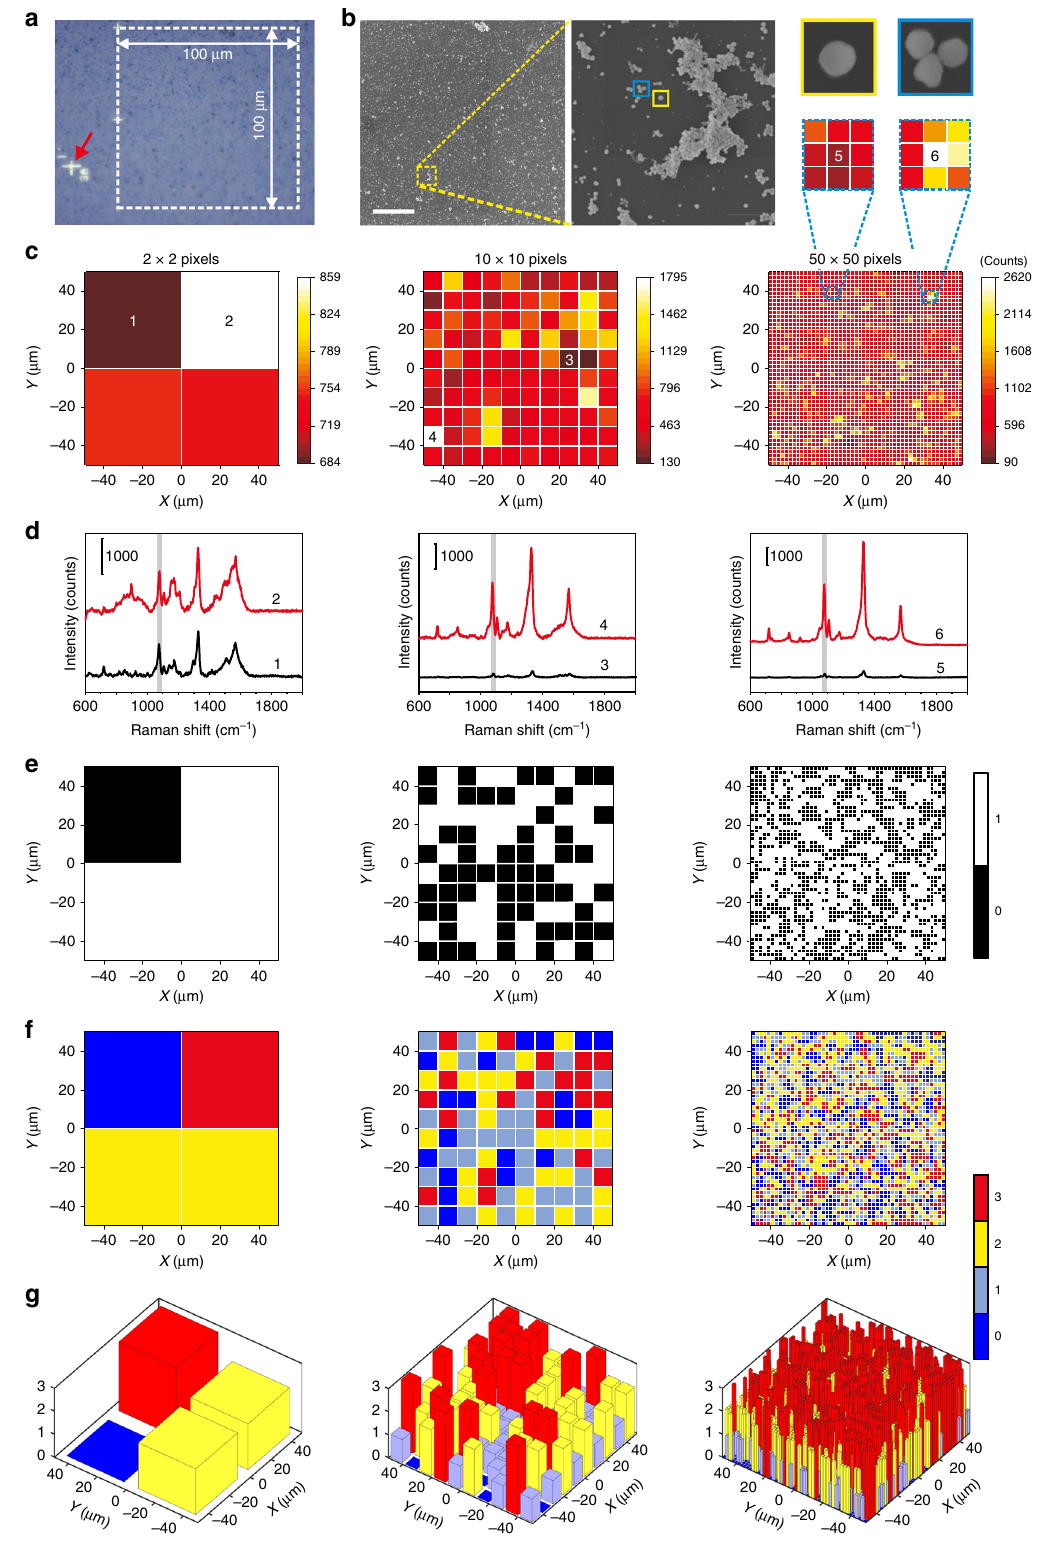
Fig. 3 Fabrication and digitization of a PUF label composed of 4-NBT GERTs. a A bright- fi eld image and b a scanning electron microscopy image (corresponds to the dashed square area in a ) of a PUF label composed of 4-NBT GERTs in an area of 100 × 100 μ m 2 on a SiO 2 substrate. Scale bars are 20 (left) and 1 μ m (right). c Readout of the PUF label by the Raman mapping (plotted using the band at 1078 cm − 1 ) and the corresponding digitization of e binary encoding and f , g quaternary encoding of Raman intensity levels at each pixel with a resolution of 2 × 2 (left), 10 × 10 (middle), and 50 × 50 (right) pixels. Panel d shows the SERS spectra at the points (1 – 6) indicated in c . Panels f and g show the two-dimensional (2D) and three-dimensional (3D) plots of digitization of the PUF label based on quaternary encoding of Raman intensity levels,